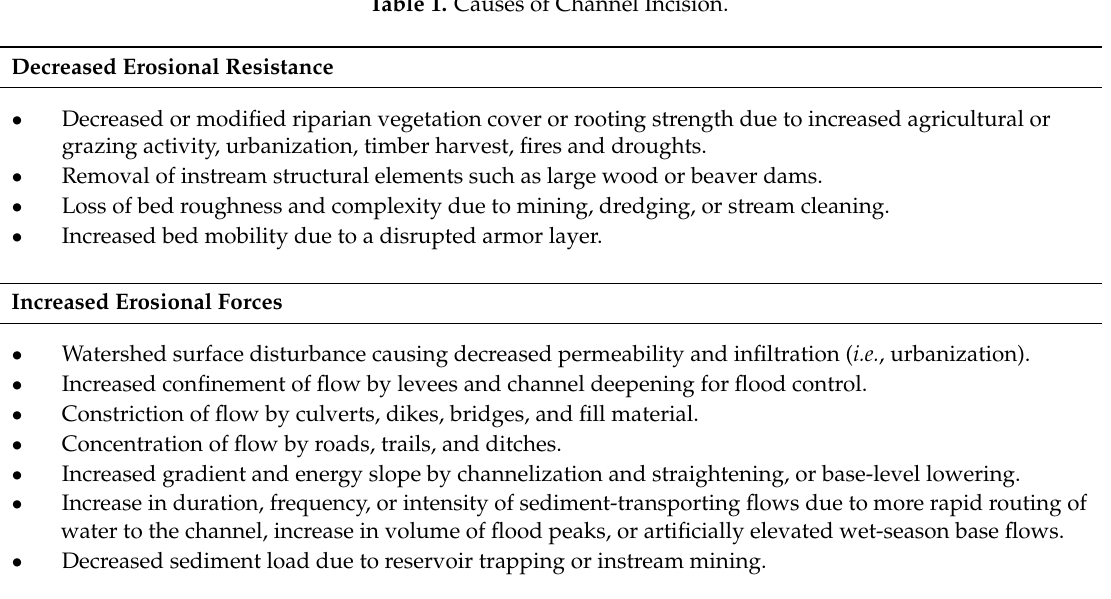
Table 1. Causes of Channel